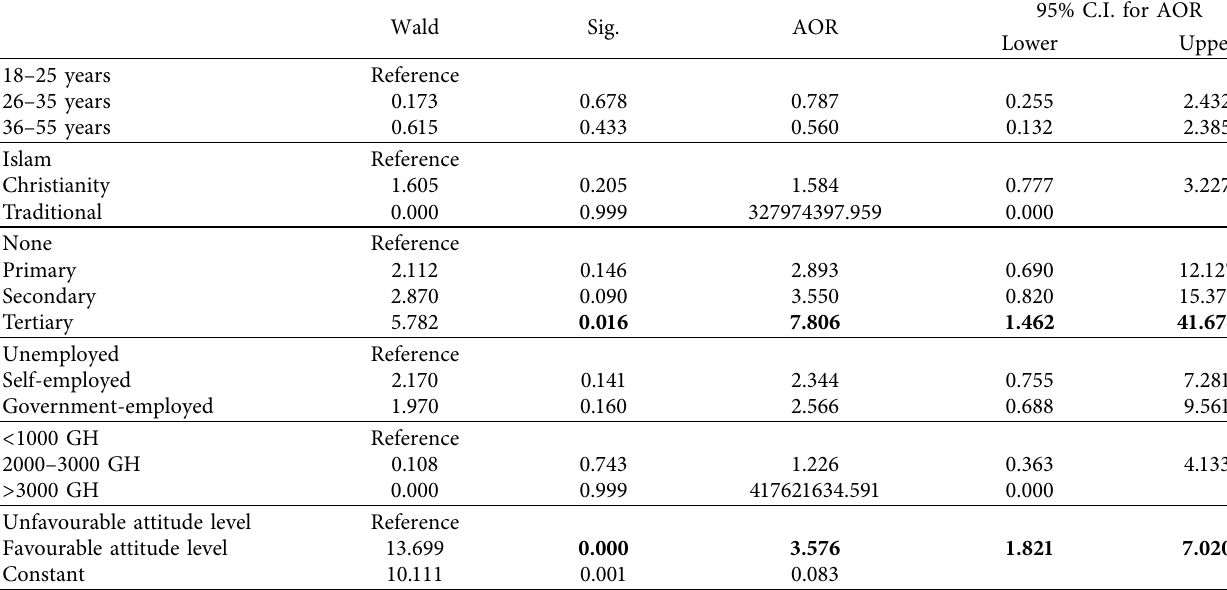
Table 6: Binary logistics for socioeconomic predictors of malaria preventive